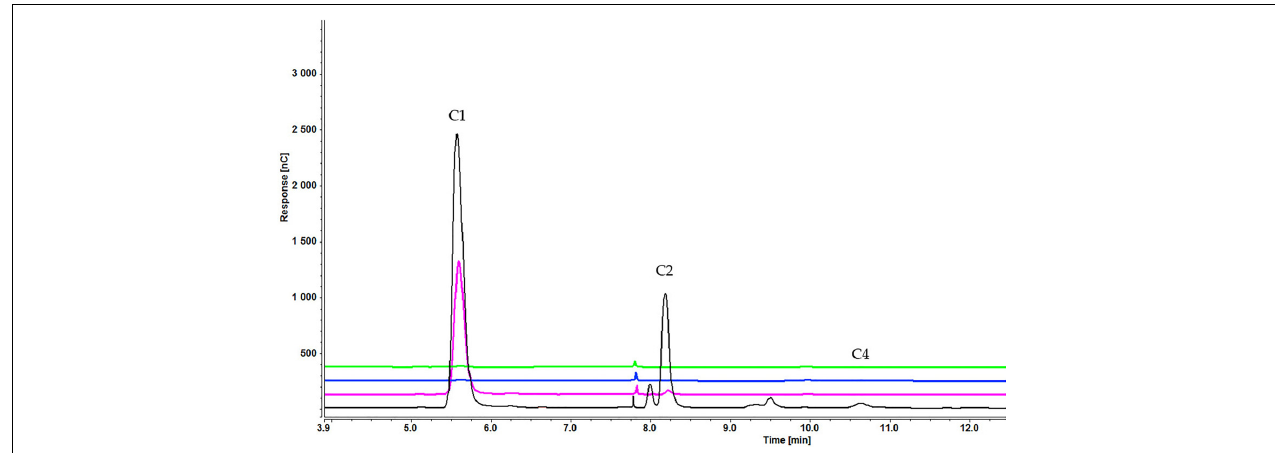
FIGURE 13 | Cellooligosaccharides concentration in the medium after 1 h (black), 3 h (pink), 5 h (blue), and 7 h (green) of induction with 0.2% cellohexaose cellotetraose (C1 = glucose, C2 = cellobiose, C4 = cellotetraose). The figure of 0.1% cellohexaose ( Supplementary Figure S7 ) is presented in Supplementary Material .